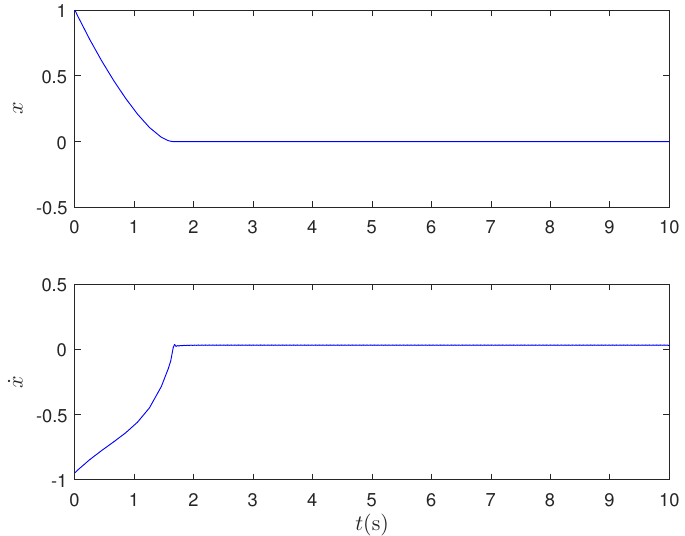
Figure 2. The fitness curve of dsRNA splicing evolutionary algorithm.